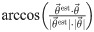
As in Fig 2 an agent flies inside a sphere (see methods 4.4).The trajectory is a sinus curve with two full periods. The amplitude of the sinus curve is 0.5 of the radius of the sphere. The sinus curve is lifted in the sphere by 0.3 units in z-direction to avoid symmetries in the depth model. The agent performs 600 steps which result in rotation angles of up to 8 degrees per frame. The initialization phase is not shown. The left figures shows the error of the translation estimates and the right figures shows the error of the rotation estimates. The y-axes show the angle error arccos(θ→est⋅θ→∣θ→est∣⋅∣θ→∣), between the estimated self-motion axis of θ→est and the axis of the true self-motion values θ→. The estimated angle errors have a pole, when the rotation gets zero at the inflection points of the sinusoidal curve (see methods 4.4). The small region around the poles are cut out in the figures. A, B) The two figures show the error of the adaptive MFA (red curve) and the original MFA (blue curve) with a constant inverse distant assumption for the original MFA. The adaptive MFA is updated every time step. The right y-axes of the figures show the averaged ratio between the rotational and translational optic flow. C, D) shows the adaptive MFA and the original MFA as in figures A and B, but with an error of 10% added to the optical flow. E, F) show different update frequencies of the depth model. All models rotate with the agent. The update frequencies are: black = 1 frame, green = 5 frames, blue = 10 frames and violet = 20 frames.